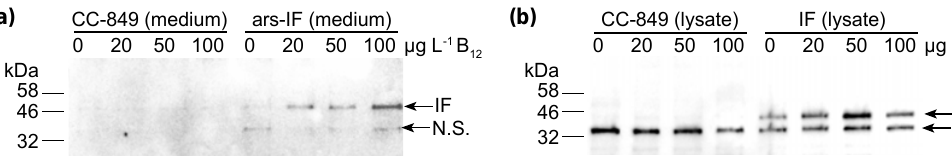
Figure 3. Accumulation of human intrinsic factor (IF) protein in C. reinhardtii ars-IF and IF cultures with increasing concentrations of vitamin B 12 (cobalamin) supplemented TAP medium. ( a ) HA-immunoblot of medium harvested from CC-849 and ars-IF cultures grown to late log phase containing 0, 20, 50 and 100 µ g · L − 1 Vitamin B 12 . Equal amounts of culture supernatant (20 µ L) loaded per lane. ( b ) HA-immunoblot of cellular lysates from CC-849 and IF cultures grown to late log phase with 0, 20, 50 and 100 µ g · L − 1 Vitamin B 12 supplemented. Equal amounts of cellular lysate standardized by OD 750 loaded. Mobility of IF protein indicated by arrow, N.S. denotes a non-specific protein cross-reacting with the HA-serum. Supplementary Figure S2 shows Coomassie stained SDS-polyacrylamide gels with total protein loaded for respective western blot samples. Table 1. Relative human intrinsic factor (IF) protein expression levels in IF and ars-IF strains for different B 12 concentration supplemented to growth medium ( n = 3 ± standard